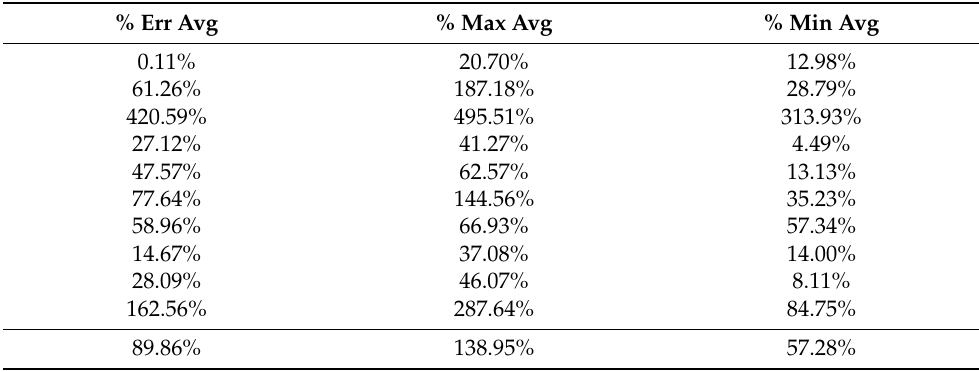
Table A11. Set 1, trials 1–10 data (all 0.5 PR